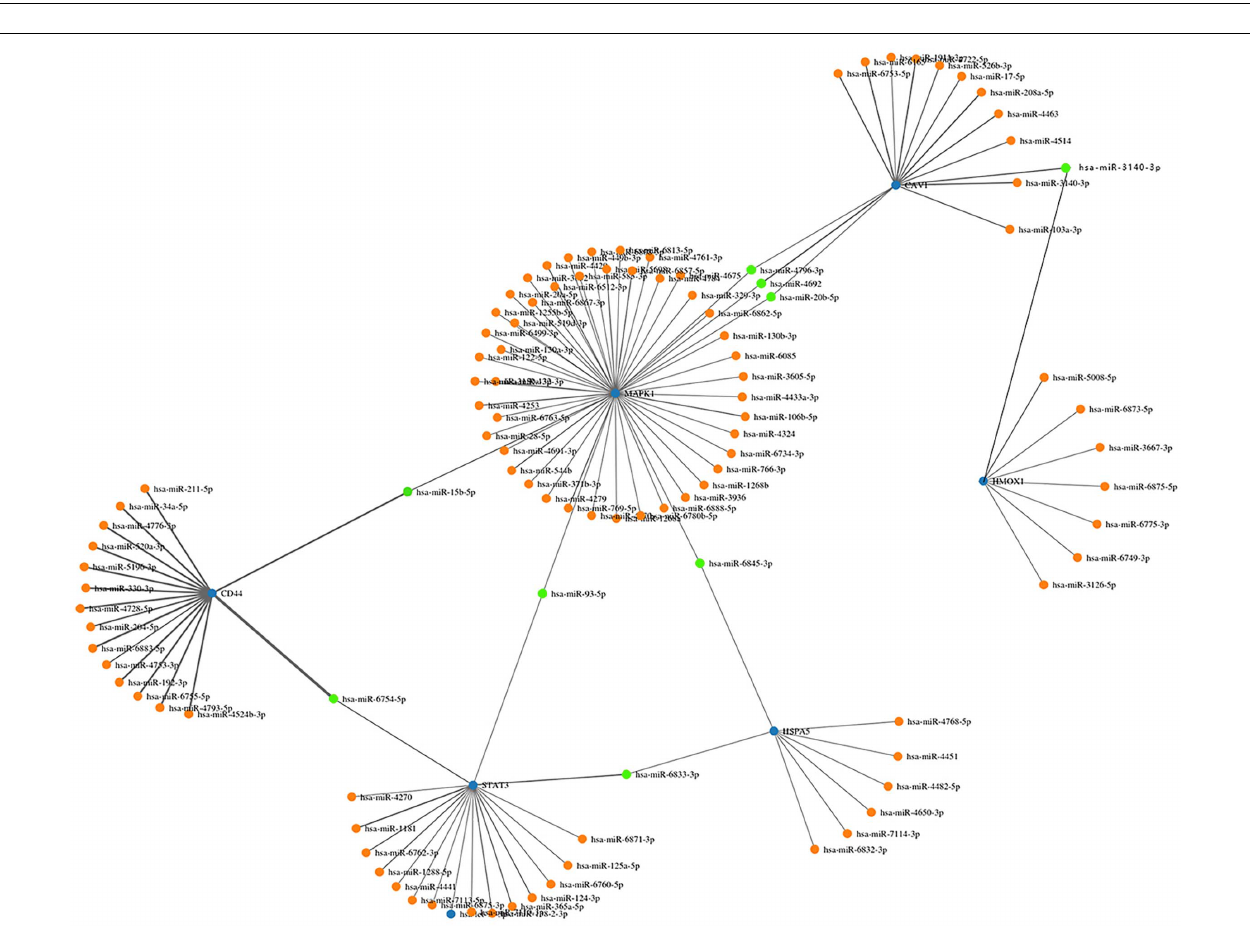
FIGURE 6 | Functional enrichment analysis of cluster 1. The TNF signaling pathway was significantly enriched.